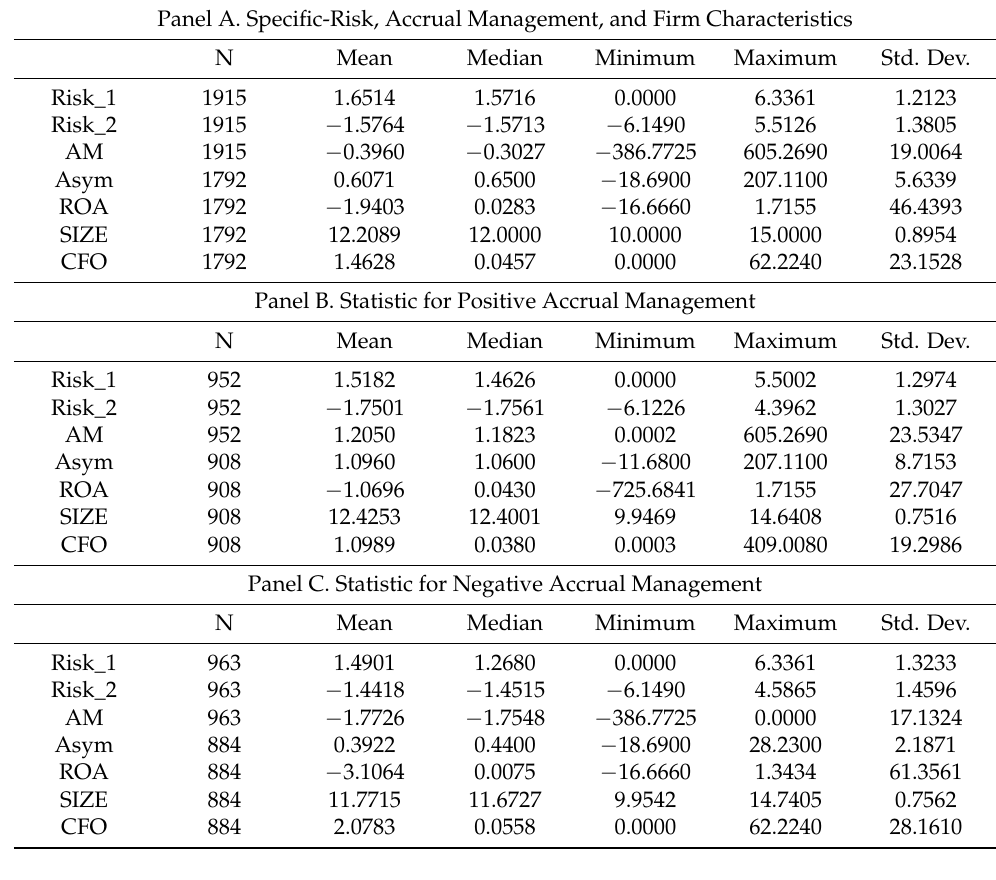
Table 1. Descriptive Statistics.